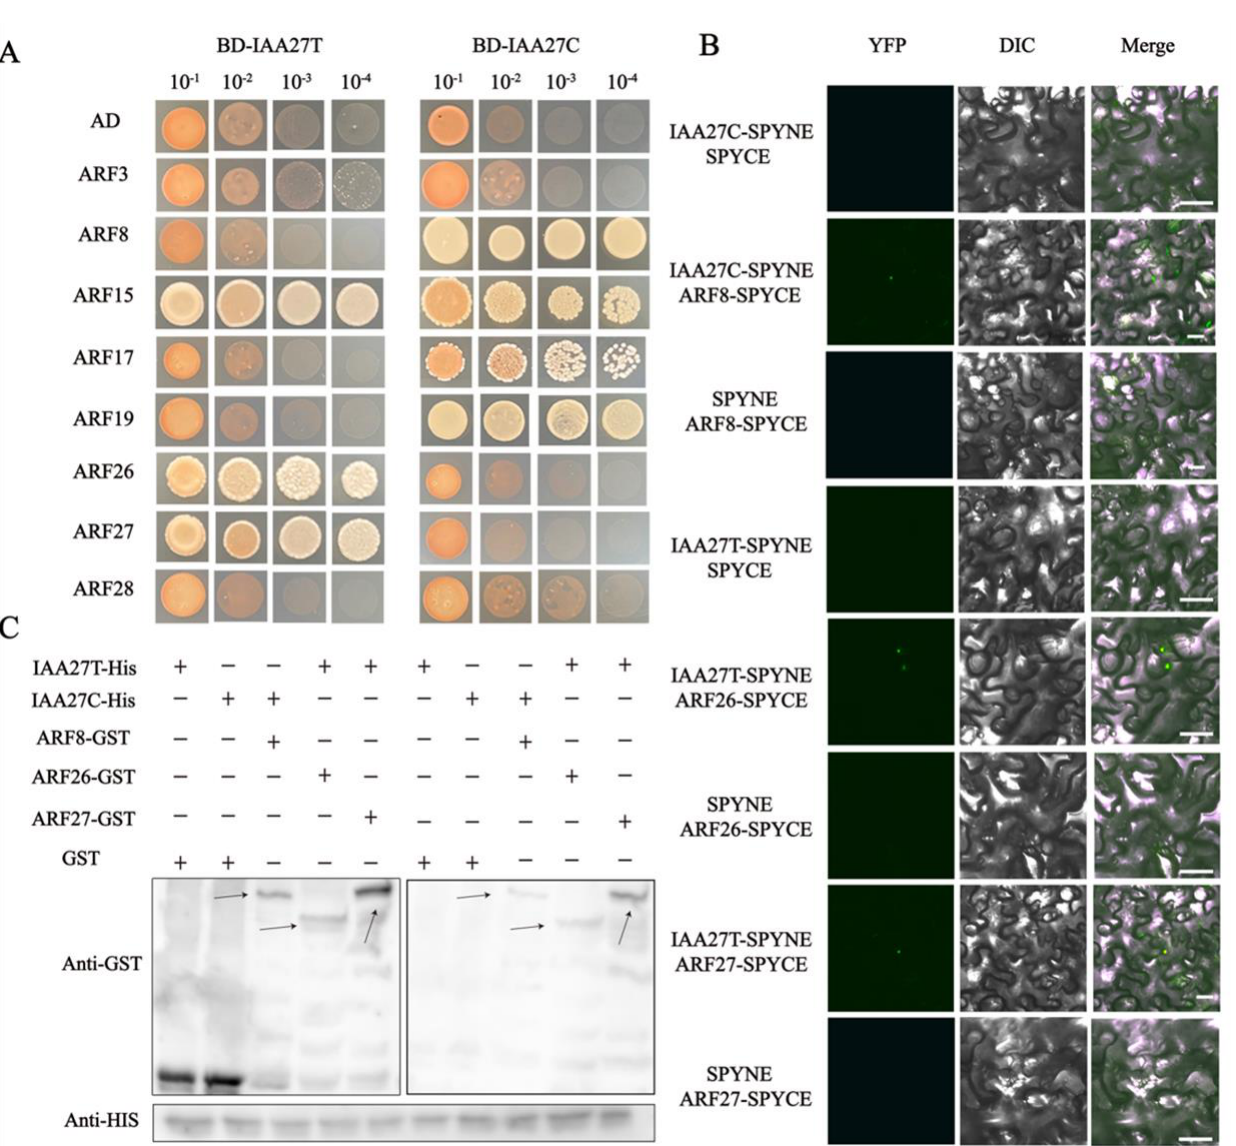
immunoblotting result was tested using anti − HIS and anti − GST antibodies. The plus and minus signs indicate the presence or absence of that protein, respectively. Black arrows indicate the positions of proteins. These assays were repeated three times with identical